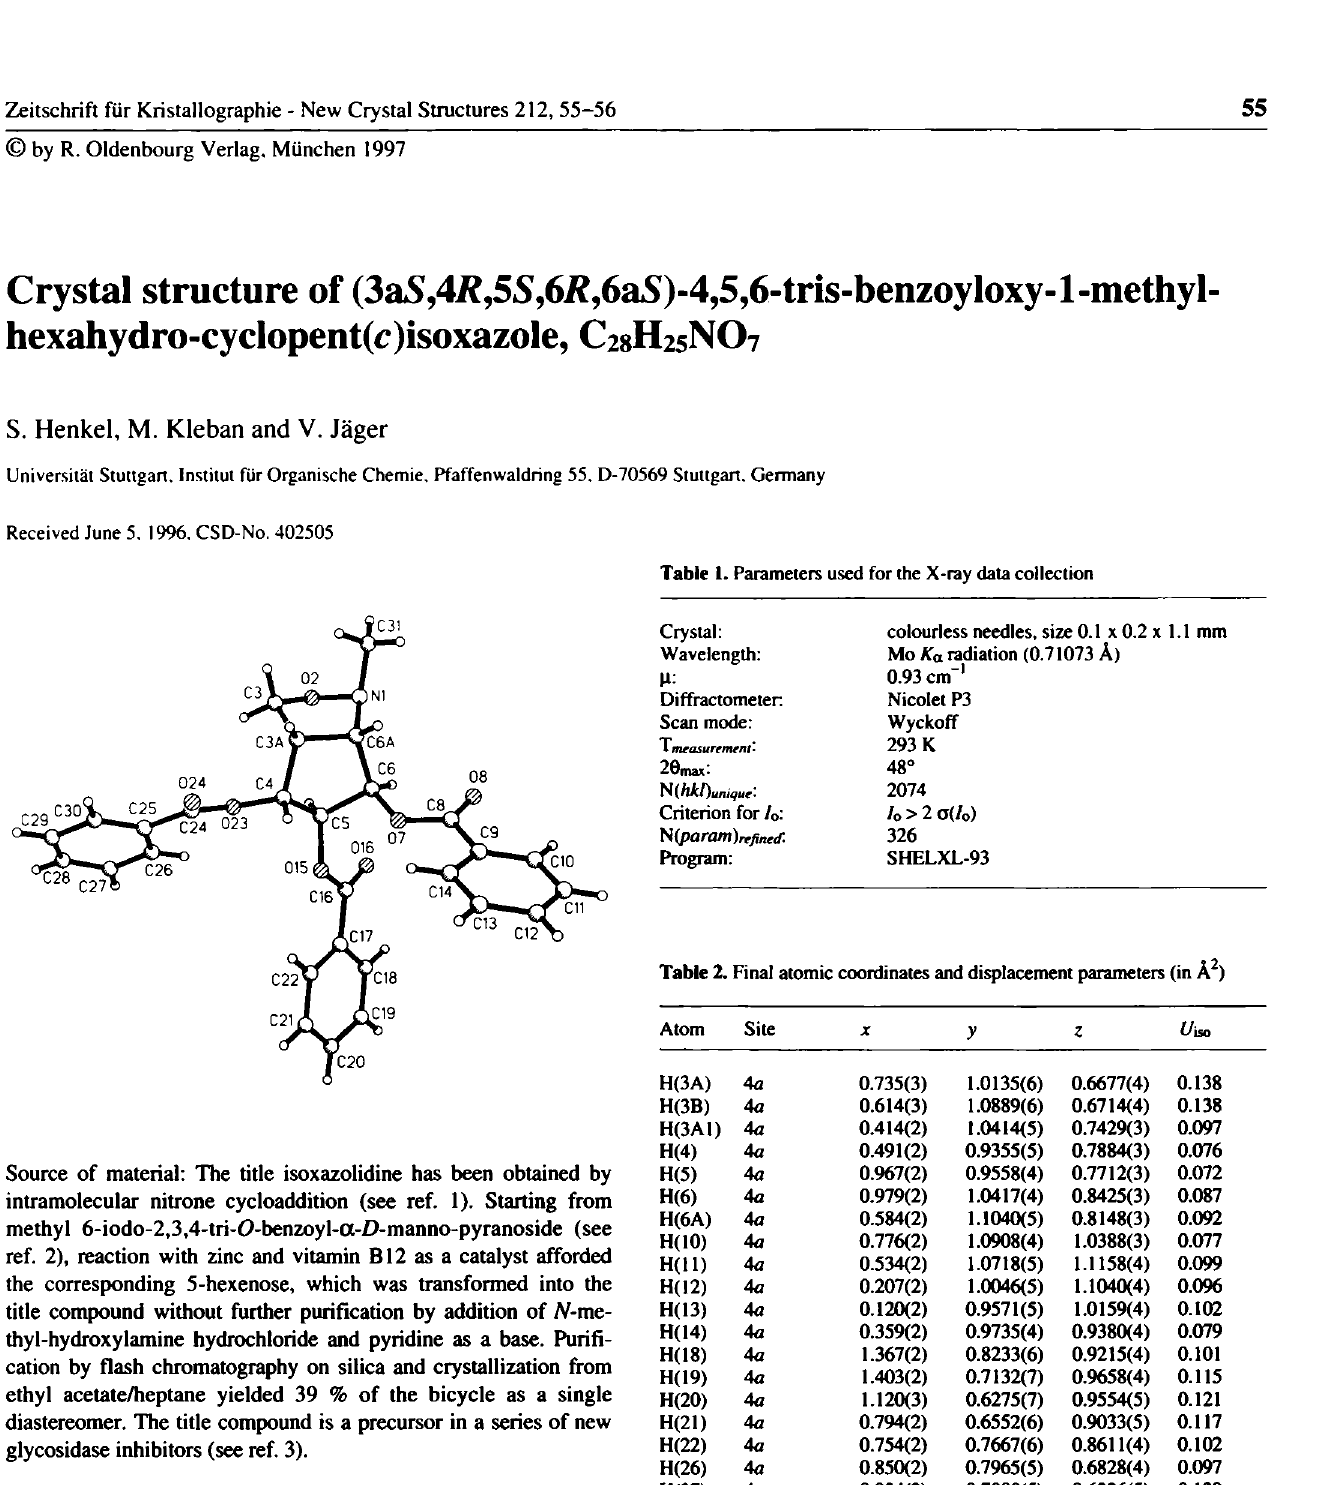
Table 3. Final atomic coordinates and displacement parameters (in Â 2